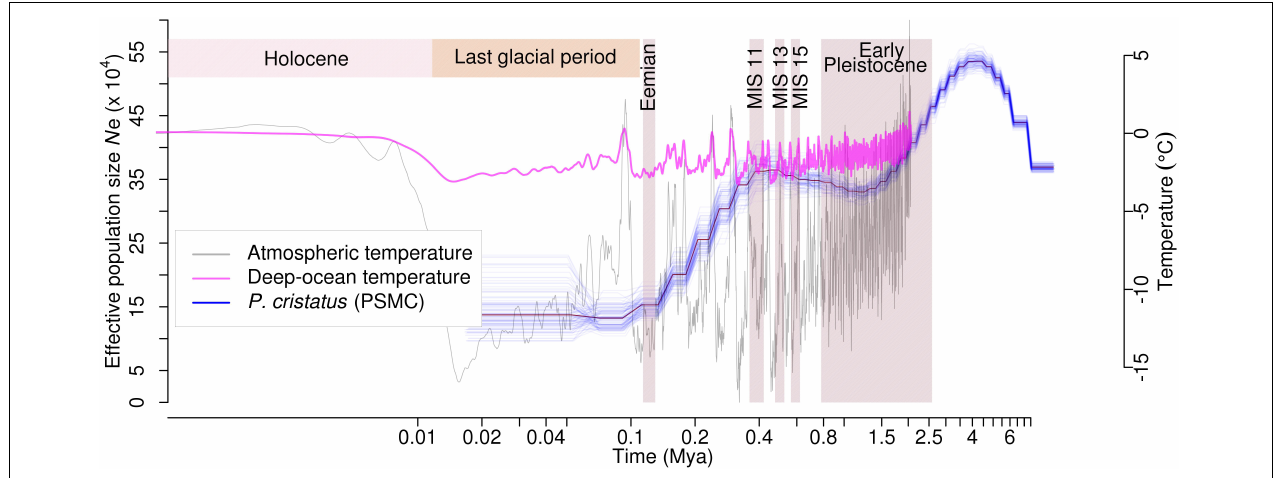
FIGURE 1 | Effective population size (N e ) estimated from PSMC analysis for Peacock. The changes in effective population size (N e ) for the peacock is shown as the blue line plot. The thick line represents the consensus, and the thin light line corresponds to 100 bootstrapping rounds. Atmospheric and deep ocean temperatures from Bintanja and Van De Wal (2008) have been